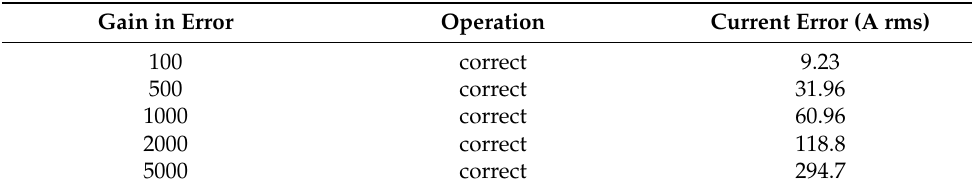
Table 3. Results of ANSI 50 — A/D error on MU.